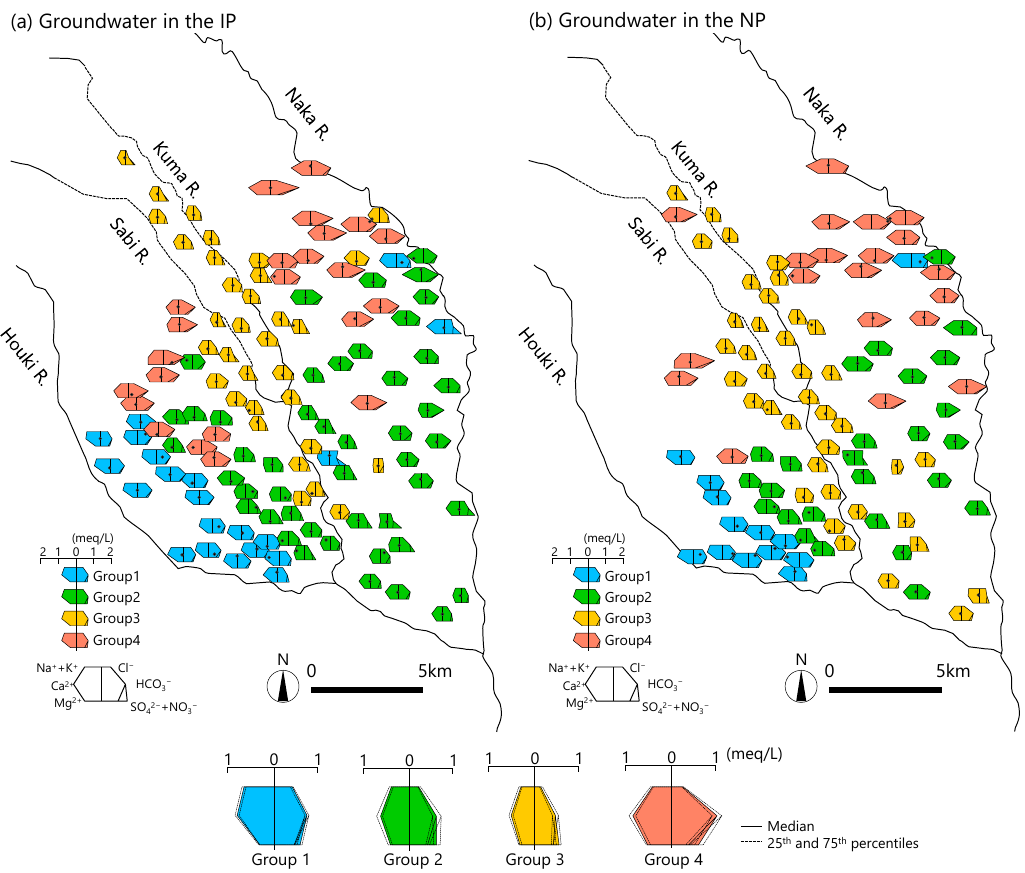
Figure 12. Spatial distribution of hexa-diagrams of groundwaters in four groups classified by the SOM in the ( a ) IP and ( b ) NP.